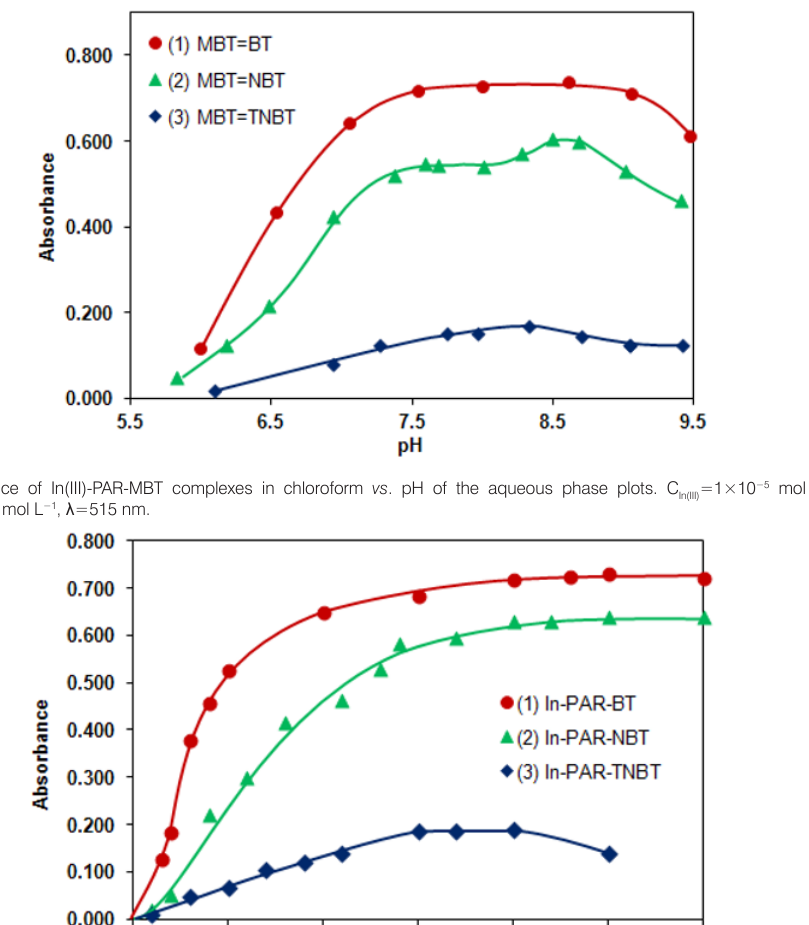
=1×10 −5 mol L −1 , C = In(III) MBT